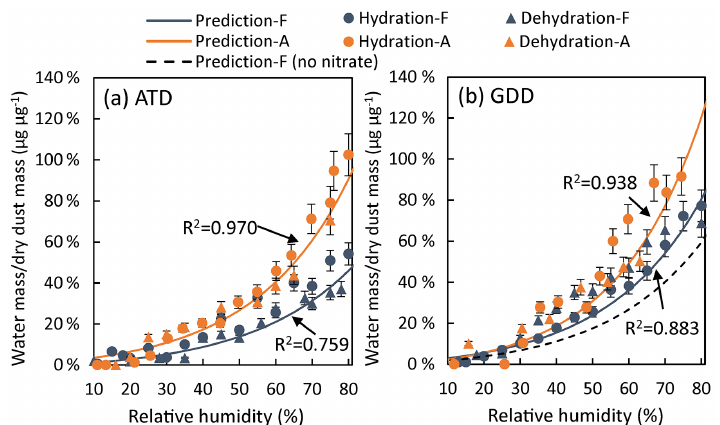
Figure 2. The fraction of water mass relative to the dry dust mass for fresh and photochemically aged (a) ATD and (b) GDD particles as a function of the relative humidity from 10% to 85%. “F” and “A” represent the fresh and aged dust particles, respectively. The water content for fresh GDD with theoretically no indigenous nitrate is also predicted and shown. The aged dust samples were collected from dust particles that were photochemically aged in the presence of NO x . The estimated nitrate concentrations for fresh and aged ATD are 0.001 and 0.011µgµg − 1 , respectively. The estimated nitrate concentrations for fresh and aged GDD are 0.007 and 0.02µgµg − 1 , respectively. The error bars were estimated from the uncertainties in the FTIR absorbance measurements of the O–H